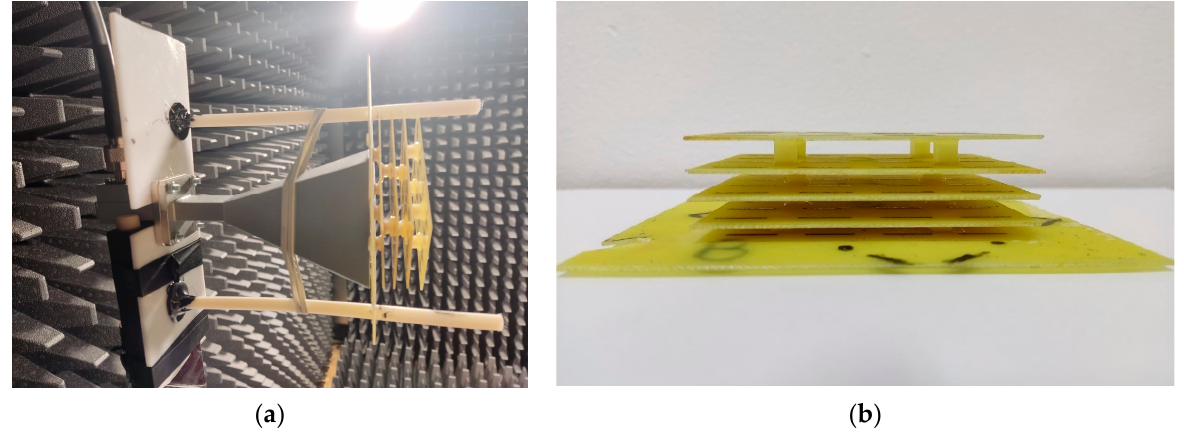
Figure 14. Radiating system consisting of a conventional pyramidal horn antenna with a multi-layer FSS structure ( a ) and FSS structure with “|”-type radiators—side view ( b ).